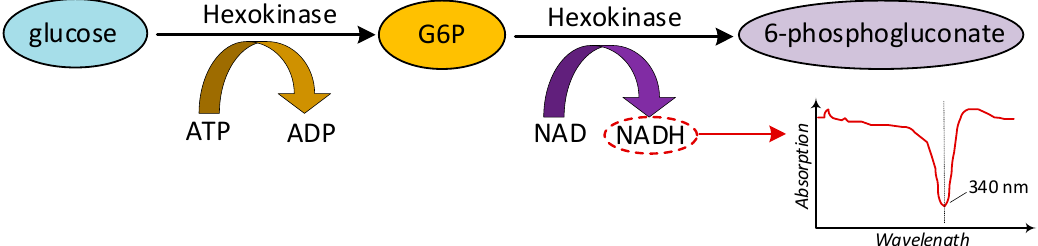
Figure 3. Hexokinase method for measurement of glucose concentration in-vitro.